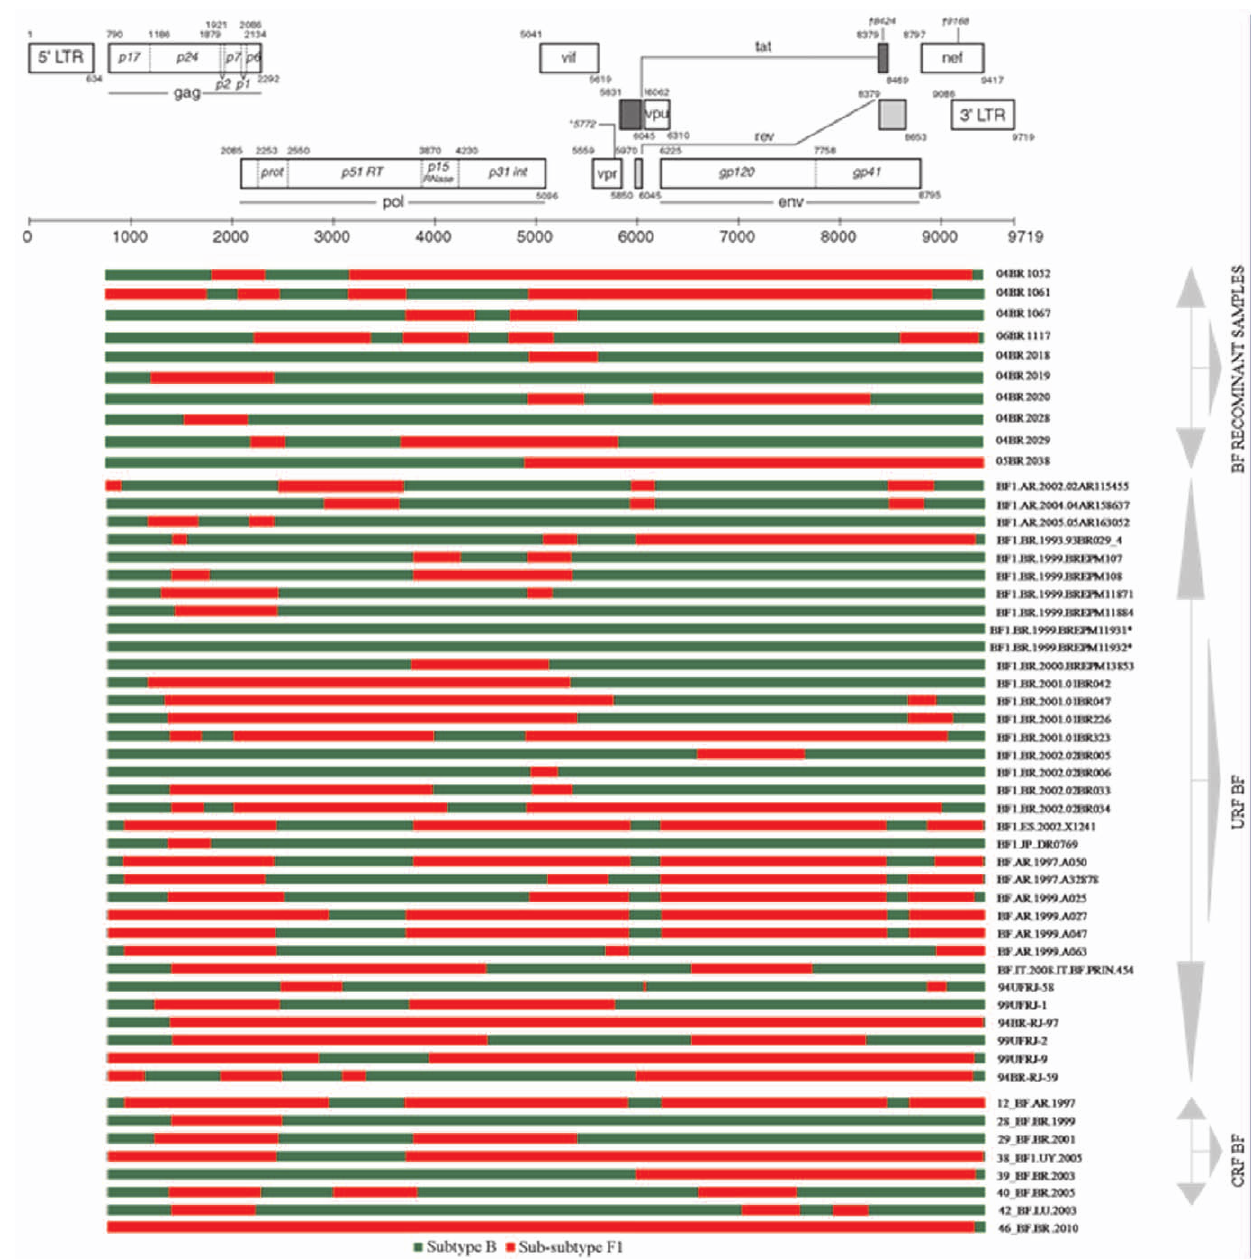
Figure 4. Schematic representation of the NFLG structure and breakpoint profiles of the BF1 sequences identified in this study and other BF1 URF and CRF published sequences. Sequences marked with the symbol (*) were originally classified as pure subtype but were characterized in the current analysis as pure B subtype, thus suggesting that a revised classification of these isolates in the GenBank and the HIV databases is appropriate. The region of subclade F1 and subtypes B are indicated at the